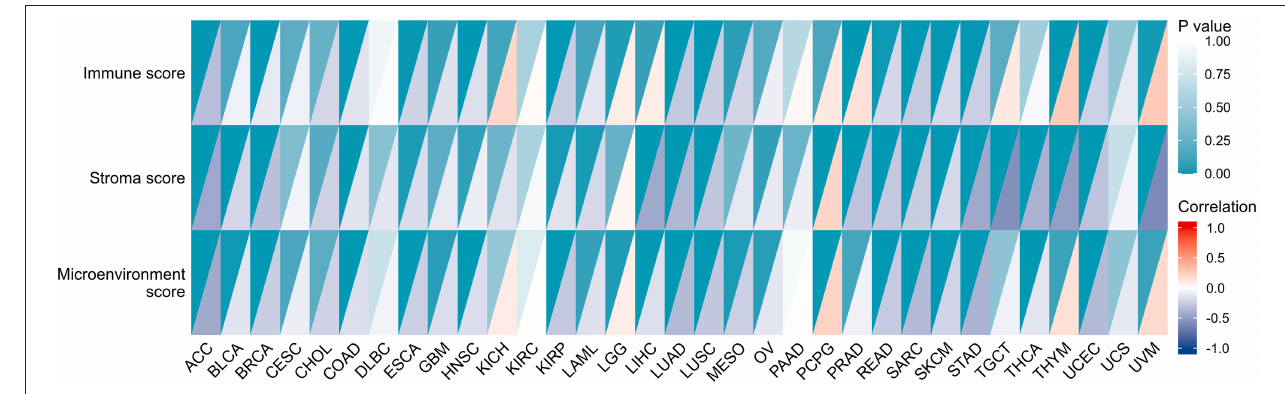
FIGURE 8 | Relationship between the expression of CBX3 and stromal score, immune score, and microenvironment score. Each color block is divided into two triangles, The depth of shade of the lower triangle signifies the magnitude of the correlation coefficient, and the depth of shade of upper triangle represents the the magnitude of p -value of the statistical analysis.